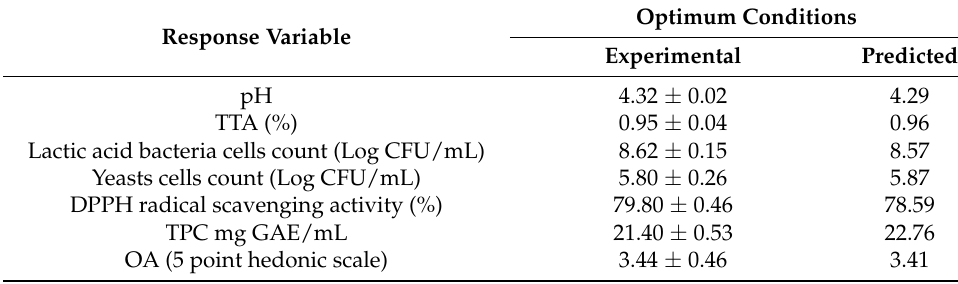
Table 5. Predicted and experimental value for optimized formulation of KLB.